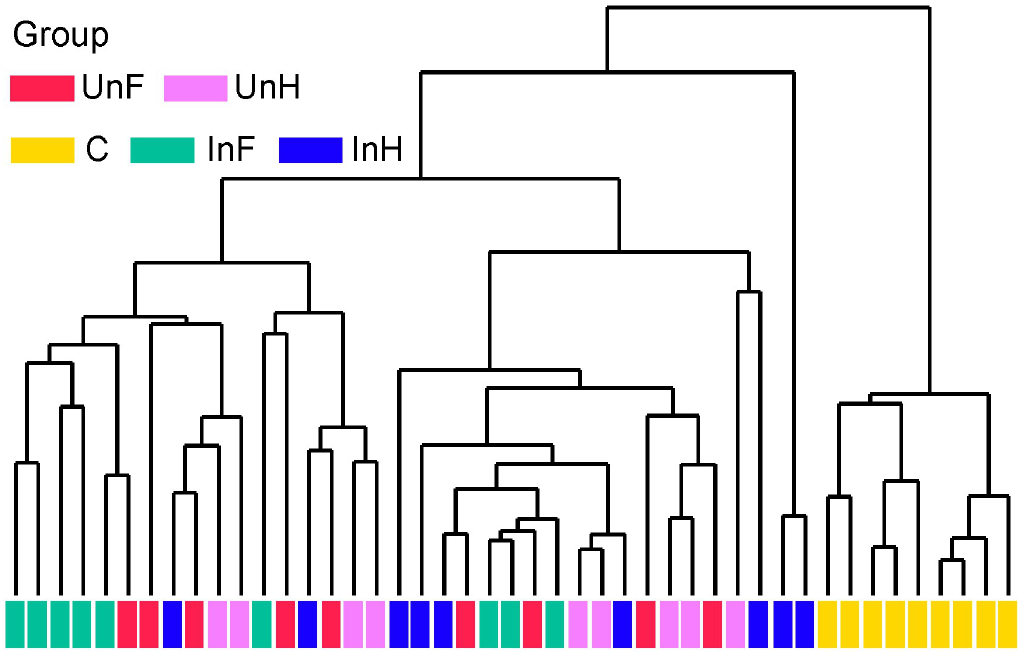
Fig 4. Cluster analysis performed on Bray-Curtis distance matrices of bacterial OTUs using an unweighted pair group mean algorithm. UnF, uninfected with S . acheilognathi in the foregut of grass carp; UnH, uninfected with S . acheilognathi in the hindgut of grass carp; C, the surface of S . acheilognathi ; InF, infected with S . acheilognathi in the foregut of grass carp; InH, infected with S . acheilognathi in the hindgut of grass carp.